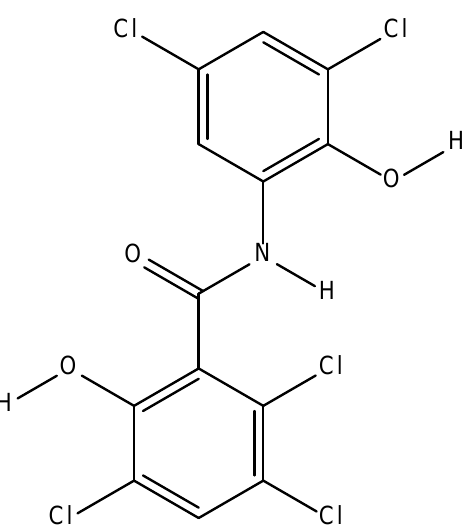
Figure 1. Molecular structure of oxyclozanide.